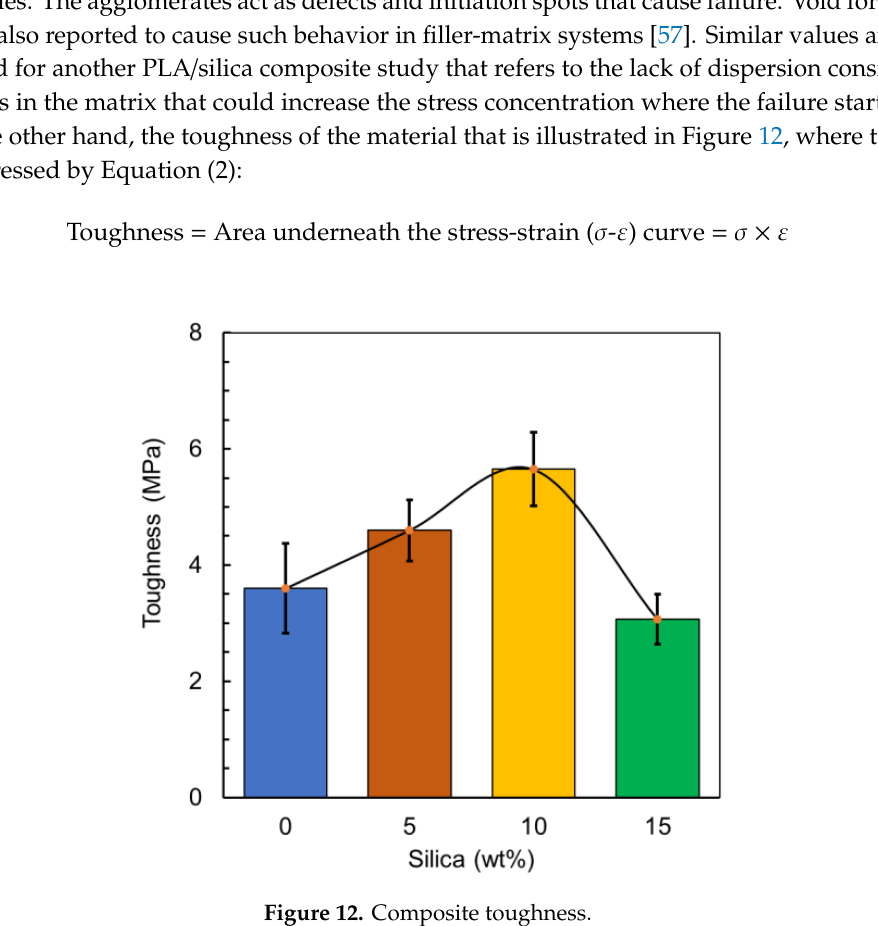
Figure 12. Composite toughness.